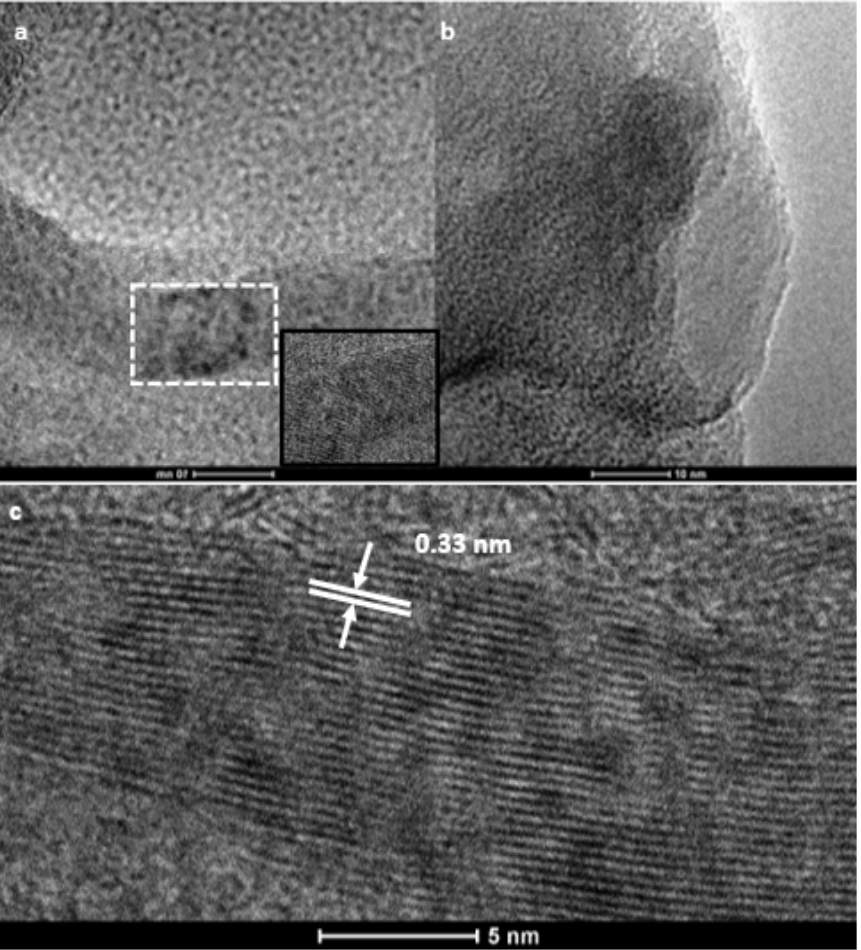
Figure 4. HRTEM image: ( a ) PKS Fe-1000 at 10 nm resolution; ( b )PKS control-1000 at 10 nm resolution; ( c ) PKS Fe-1000 at 5 nm resolution.